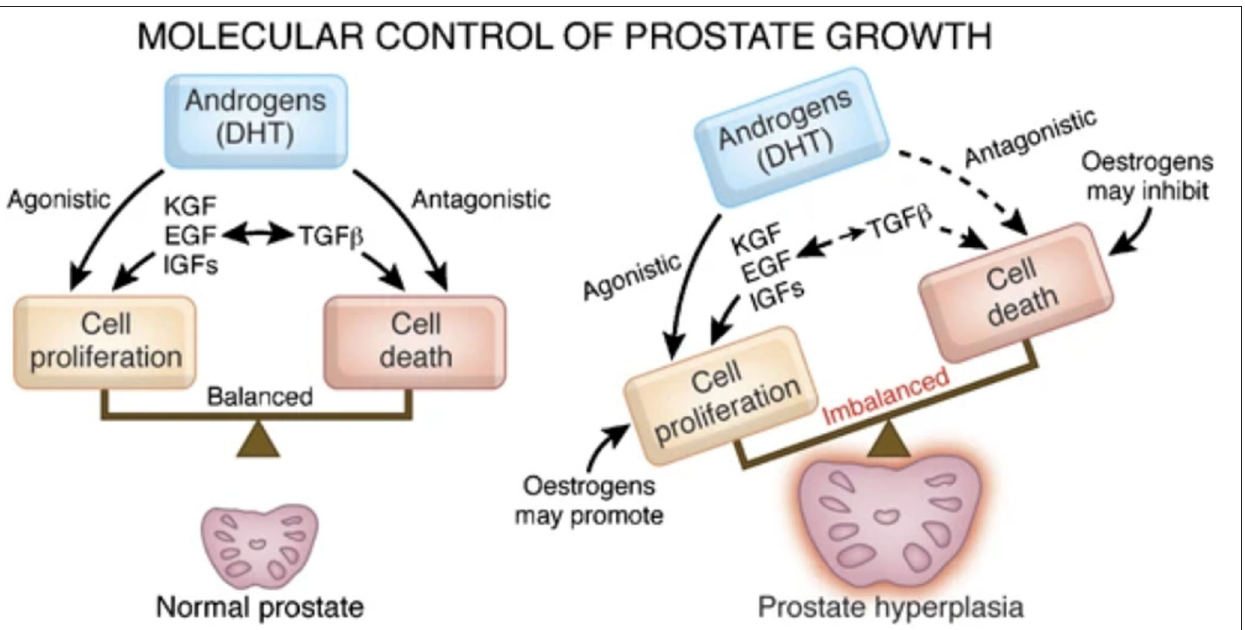
FIGURE 6 | Re-published: Steroids involved in keeping the balance of human prostatic growth. Interaction of OT and androgens as well as a direct effect of OT is not displayed by Roehrborn (194). Reprinted by permission from Springer Nature: Nature, International Journal of Impotence Research, Pathology of benign prostatic hyperplasia, Roehrborn ( 194) https://www.nature.com/articles/ijir200855.